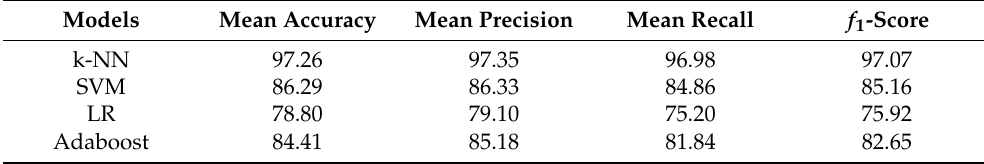
Table 2. Result for 10-fold cross validation of the models.